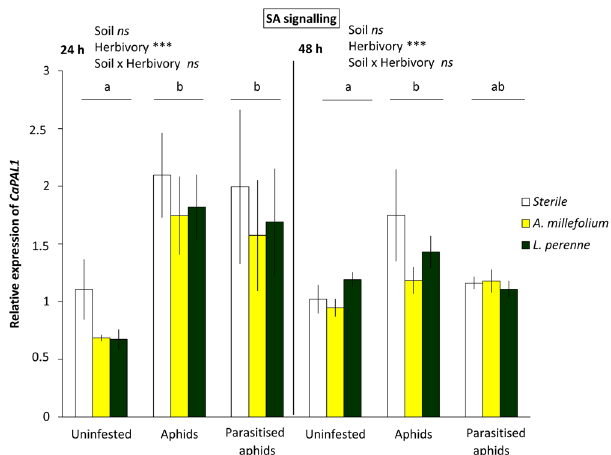
Figure 2. Expression levels of CaPAL1 in C. annuum in uninfested, aphid-infested, or parasitised aphids- infested plants, each grown in sterile soil, or inoculated with living soil conditioned by the plants A. millefolium or L. perenne . Bars represent mean CaPAL1 expression levels normalised as 2 − ∆∆ Ct with standard error bars (n = 4). Bars marked with different letters are significantly different (LSD, P < 0.05), with separate analysis for the two time points (24 and 48 h after aphid